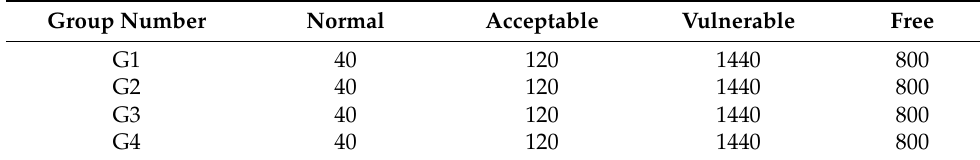
Table 2. The distribution of the collected data